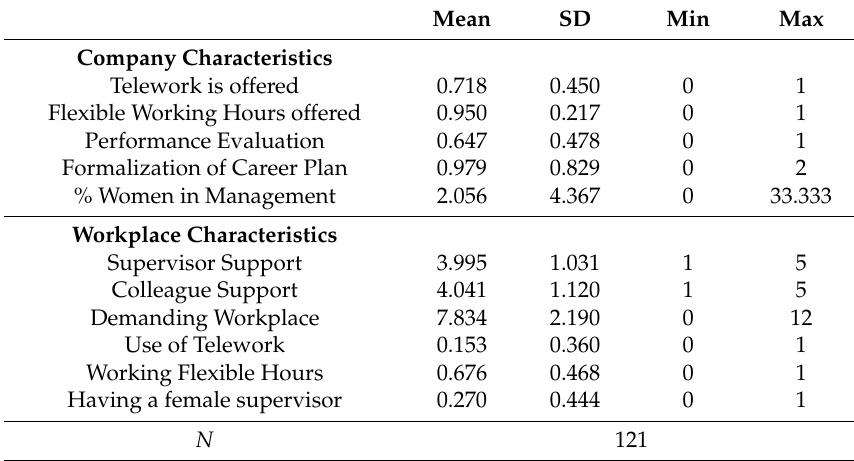
Table 3. Means and standard deviations of study variables for